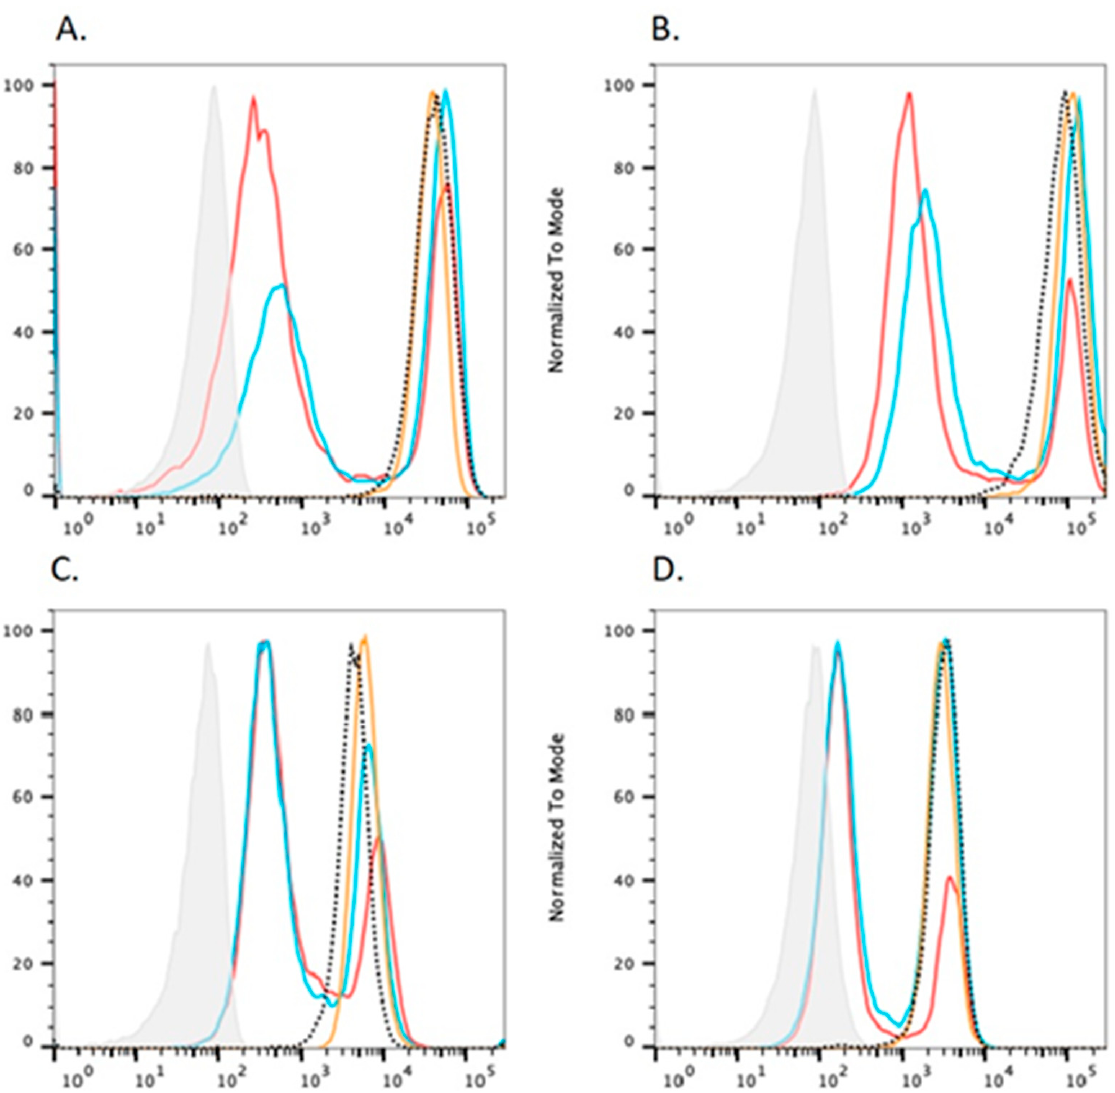
Figure 2. The effect of c.259G>A mutant hPGAP3 , driven by the strong pME promoter, on the expression of GPI-APs in PGAP2 - and PGAP3 -deficient Chinese hamster ovary (CHO) cells. Isotype (grey); PME WT hPGAP3 -HA (red); PME c.284A>G mutant hPGAP3 -HA (blue); PME empty (yellow). The wide type hPGAP3 and hPGAP3 c.259G>A reduced the expression of GPI-APs to similar extents ( A ). CD59; ( B ). CD55; ( C ). uPAR; ( D ). FLAER in PGAP2- and PGAP3- double deficient CHO cells.